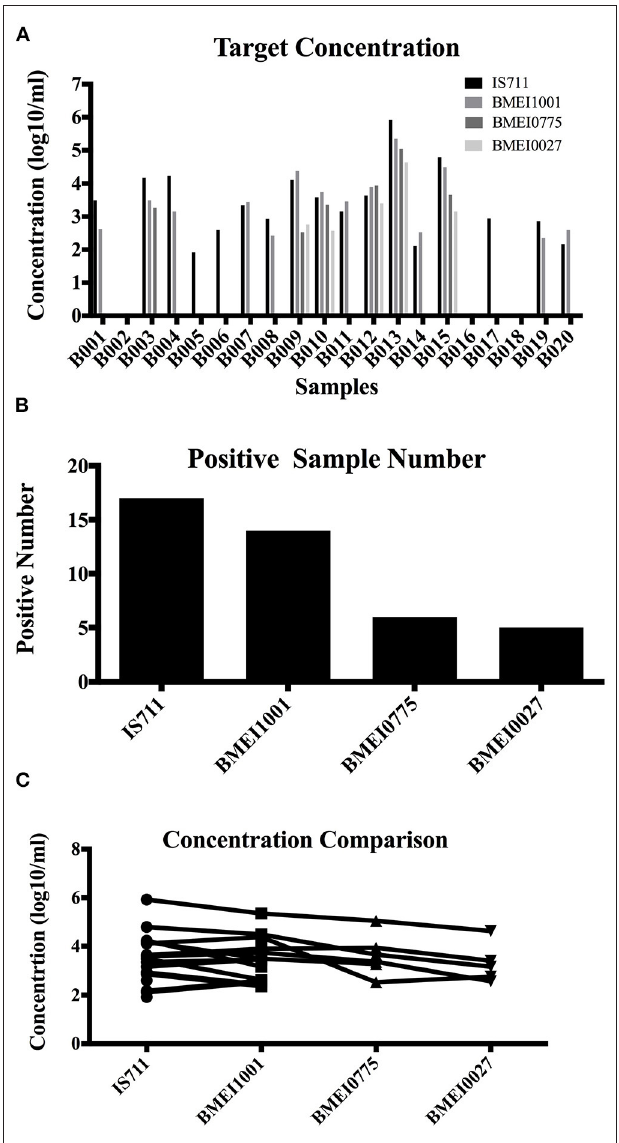
FIGURE 4 | Detection of clinical blood samples of human brucellosis patients. A total of 20 samples from human brucellosis patients were tested with IS711, BMEI1001, BMEI0775, and BMEI0027 assays, and the target concentration was calculated for each sample. Target concentration (A) and positive number (B) of IS711 and BMEI1001 was higher than that of BMEI0775 and BMEI0027 (C) .